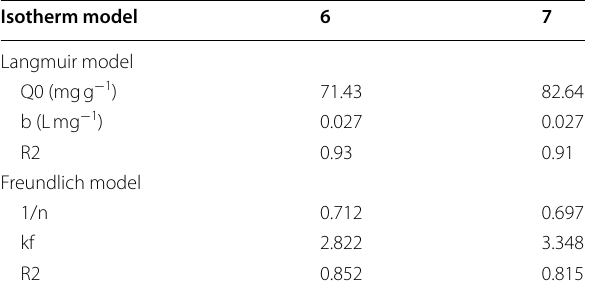
Table 1 Langmuir and Freundlich models for the removal safranin dye by copolymer 6 and composite 7 Isotherm model 6 Langmuir model